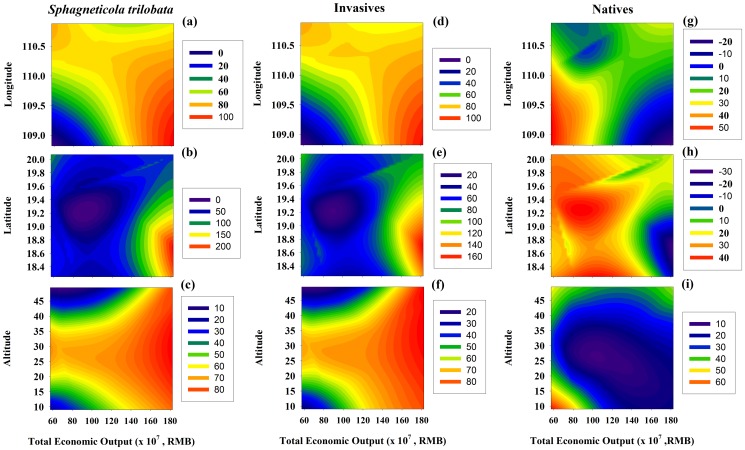
Geographical distribution patterns of the coverage of S. trilobata (a, b, c), all invasive plants (d, e, f), and native plants (g, h, i) across different geographical locations (Longitude, Latitude, Altitude) and total economic outputs.The total economic output value included farming, forestry, and animal husbandry in each sampled cities in 2006.